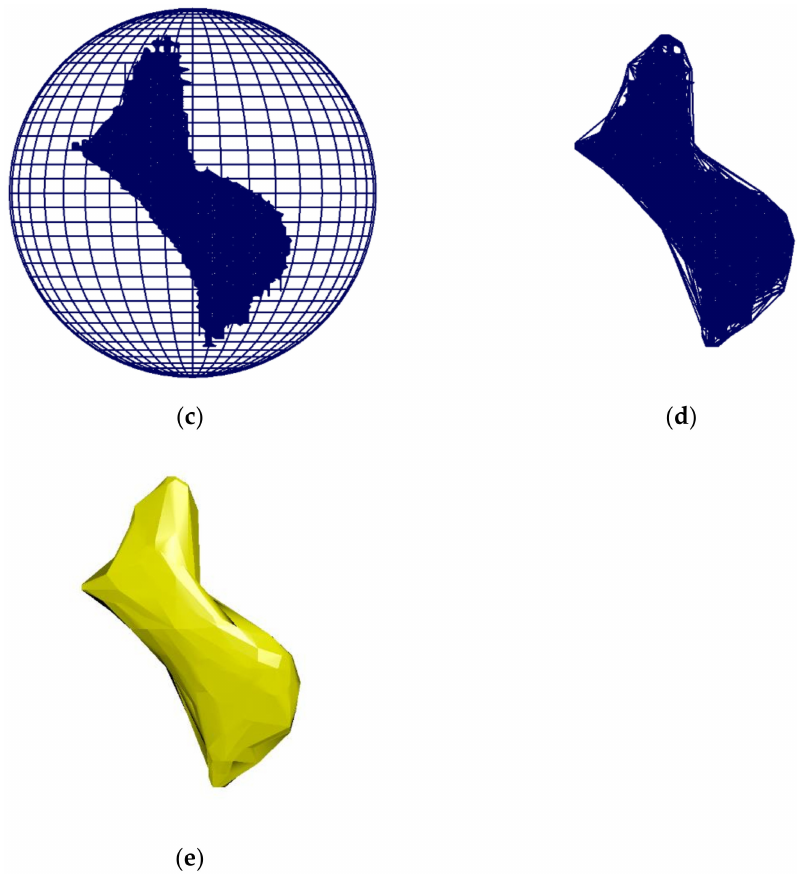
Figure 1. Surface reconstruction of the skull and masseter muscle. The skull and superficial part of the masseter muscle were surface-reconstructed ( a ). The surface-reconstructed superficial part of the masseter muscle is not smooth and realistic due to a whole segmentation that was not performed ( b ). The surface model of the sphere is made ( c ) and wrapped ( d ) to the superficial part of the masseter. The superficial part of the masseter is accurately reproduced ( e ). (Maya, version 2018, www.autodesk.com accessed on 6 May 2021).